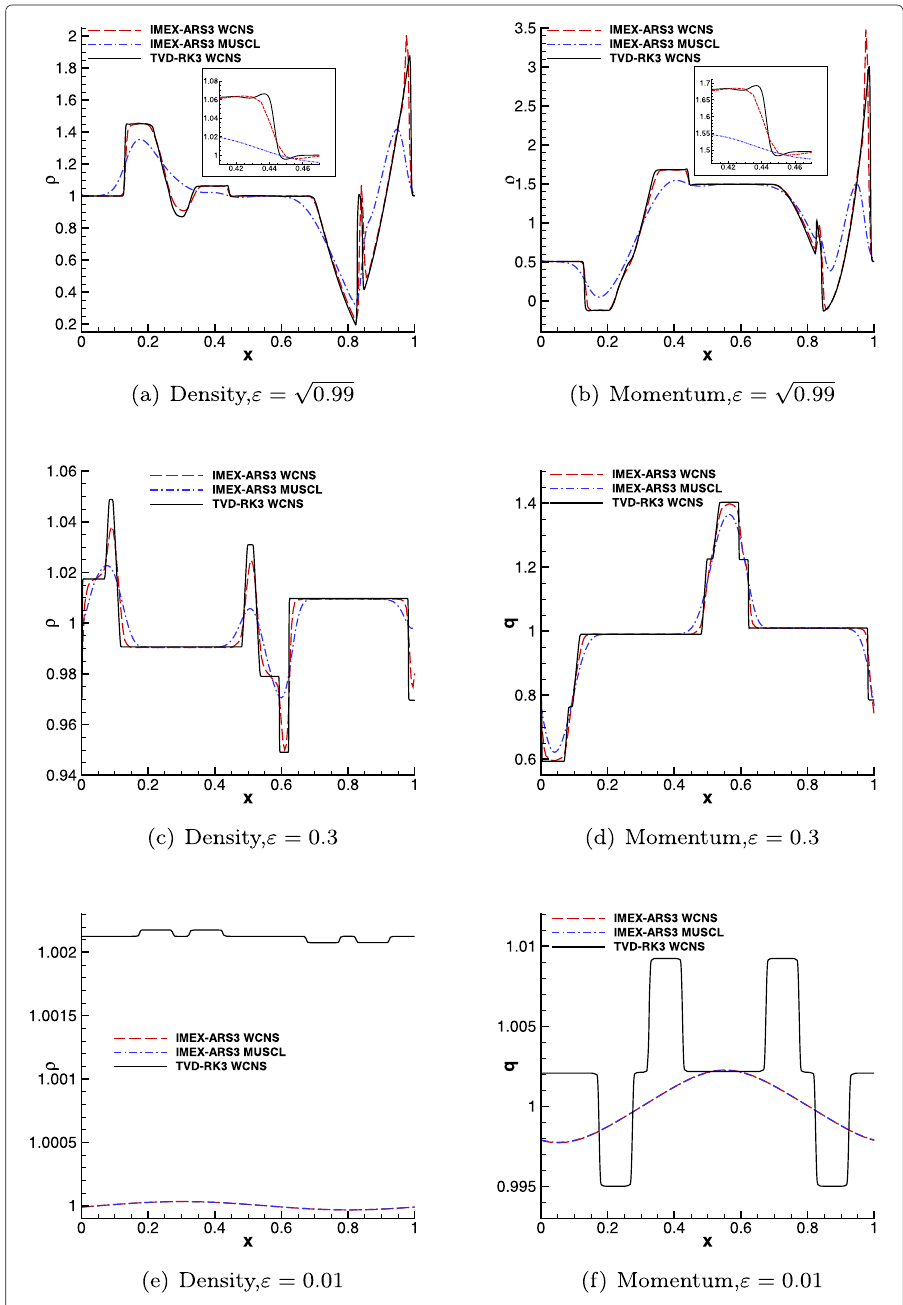
Fig. 1 Example 2. Density (left) and momentum (right) calculated by the GSA IMEX-ARS3 WCNS and the GSA IMEX-ARS3 MUSCL with N = 200 cells and the TVD-RK3 WCNS with N = 2000 cells at t = 0.05. The values of √ 0.99 (top), 0.3 (middle) and 0.05 (bottom). a Density, ε = the Mach number are ε =